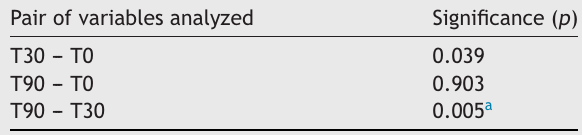
Perceptual-auditory assessment